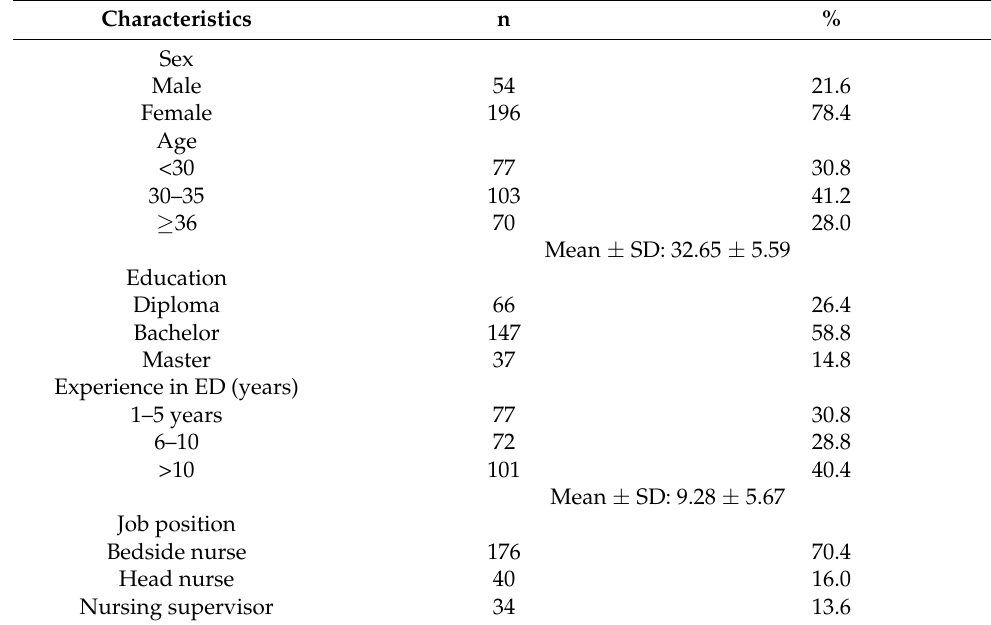
Table 1. Sociodemographic characteristics of participants ( N =